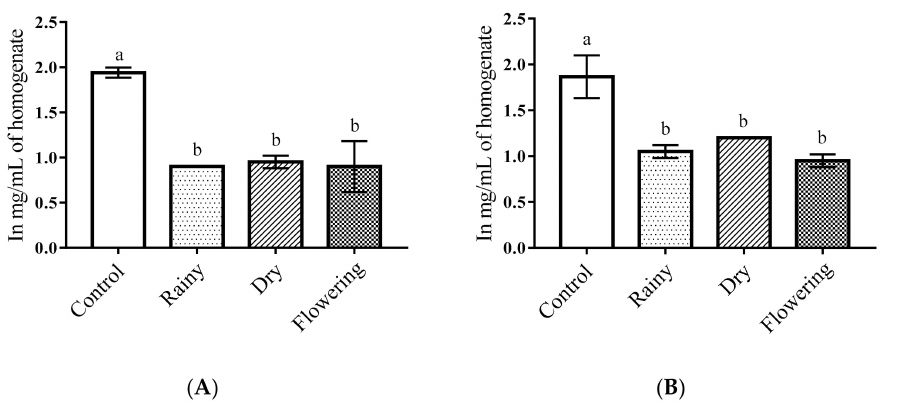
Figure 2. Biochemical changes in total proteins of Ae . aegypti and Ae . albopictus larvae. Changes in total protein levels between Ae . aegypti ( A ) and Ae . albopictus ( B ) larvae treated and not treated with the essential oils of Lippia grata Schauer. Different lowercase letters in the bar denote significant difference ( p < 0.05). Bars represent standard deviations ( n = 3). Values estimated by one-way ANOVA followed by the Tukey test. Control, untreated